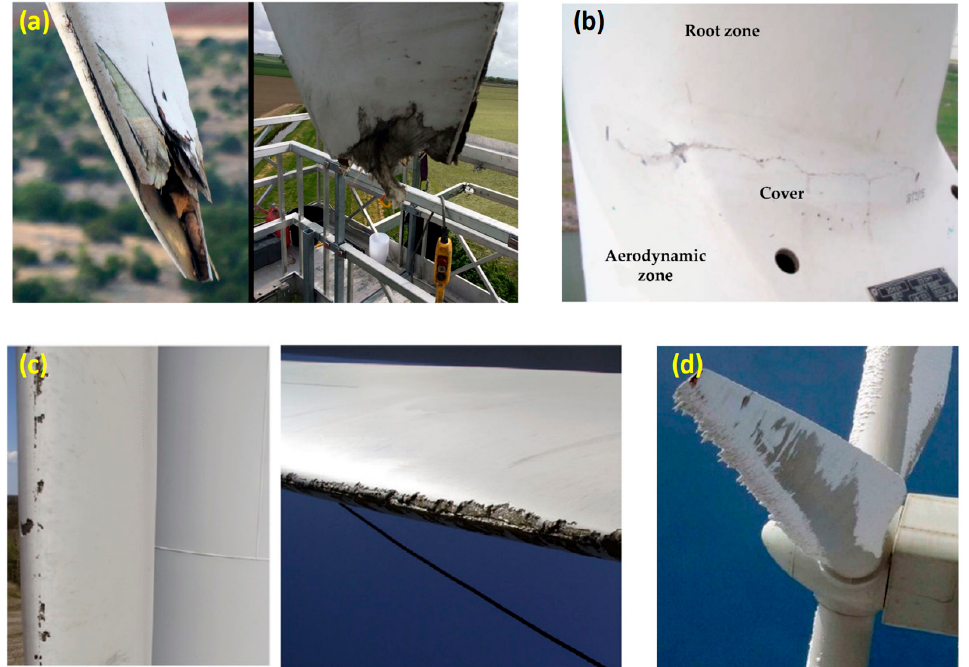
Figure 3. Potential damage sources of wind turbine blades: ( a ) damage from lightning, ( b ) failures due to fatigue, ( c ) leading-edge erosion, and ( d ) damage from icing (adapted from [6] ).